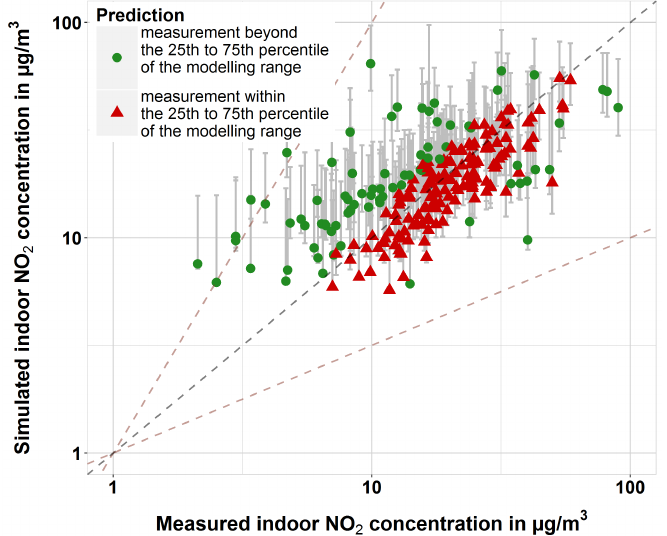
Figure 13. Validation for NO 2 . The red dot represents the measurement that is within the corresponding 25th to 75th percentile of the modelling range, while the green dot is beyond that range. For NO 2 65% of the dots (172 out of 265) are within the